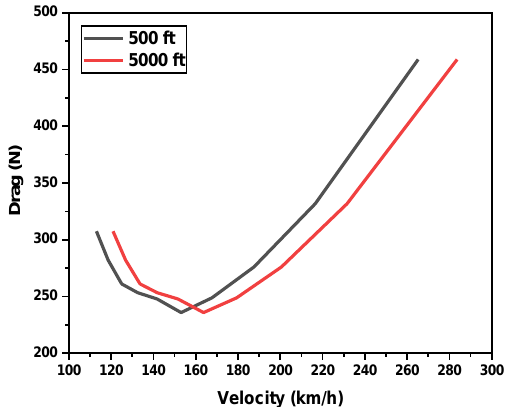
Figure 2. Drag vs. velocity for 500 and 5000 ft altitudes.